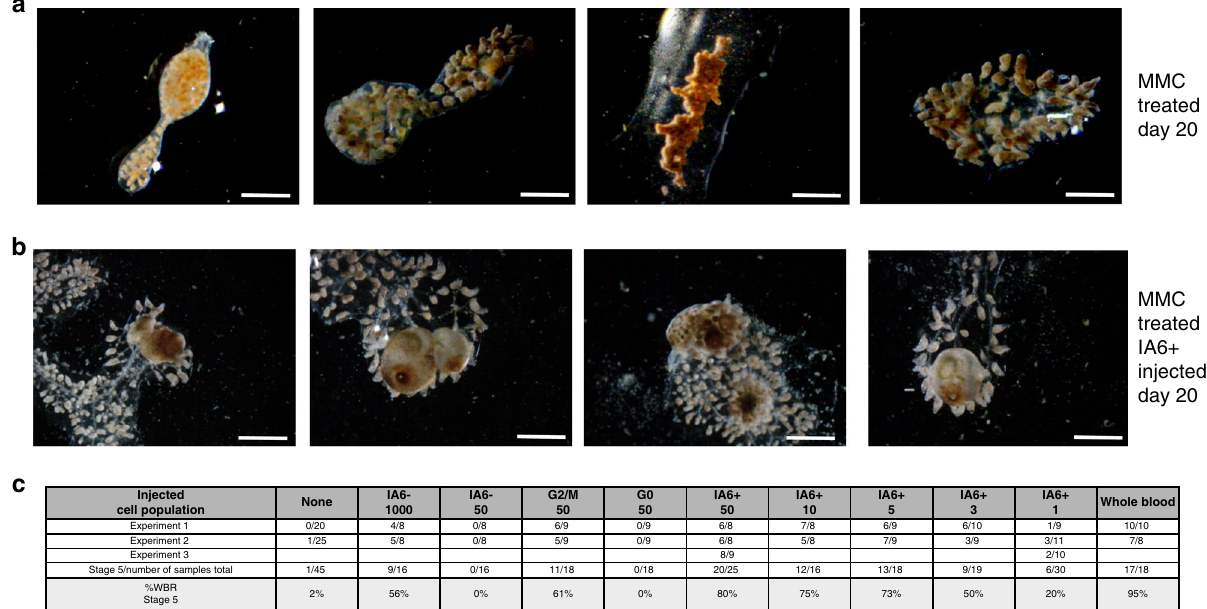
Fig. 3 IA6 + cells are required for whole body regeneration. a Mitomyin C (MMC) treatment prevents regeneration. Bright fi eld images of vessel fragments 20 days post MMC treatment. Vessel fragments were treated with MMC for 16 h immediately after surgery. After 16 h, MMC was removed, and the samples followed for 20 days. Scale bar 1 mm. b Injection of IA6 + cells 24 h after MMC treatment rescues WBR. Bright fi eld images of MMC-treated vessel fragments 20 days post injection of IA6 + cells. Scale bar 1 mm. c Table showing rates (percentages) of WBR (reaching stage 5) 20 days after injection of different cell populations. For each condition, 16 – 20 samples were injected in two independent